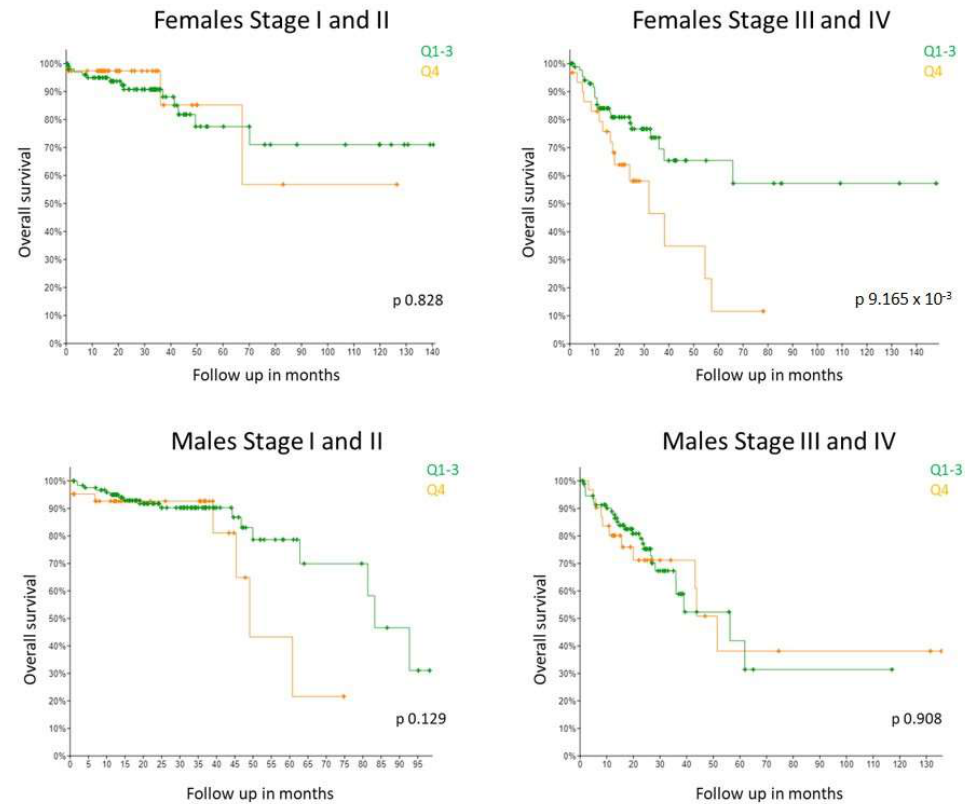
Figure 5. High GPER1 expression significantly associated with worse overall survival rates exclu- sively in TNM stage III and IV CRC female patients, and did not correlate with survival in TNM stage I and II nor male patients at any stage in the TCGA dataset. Kaplan–Meier survival analysis by GPER1 expression in TCGA cohort divided by the last quartile (Q4 vs. Q1–3). Increased GPER1 expression (Q4) significantly correlated with poor survival in the 150 females at stage III and IV ( p = 9.165 × 10 −3 ) and not in the 130 females at stage I and II ( p = 0.828). In the male CRC patients, GPER1 expression did not associate with survival at any stage (168 at stage I and II; 131 at stage III and IV) ( p = 0.129; p =